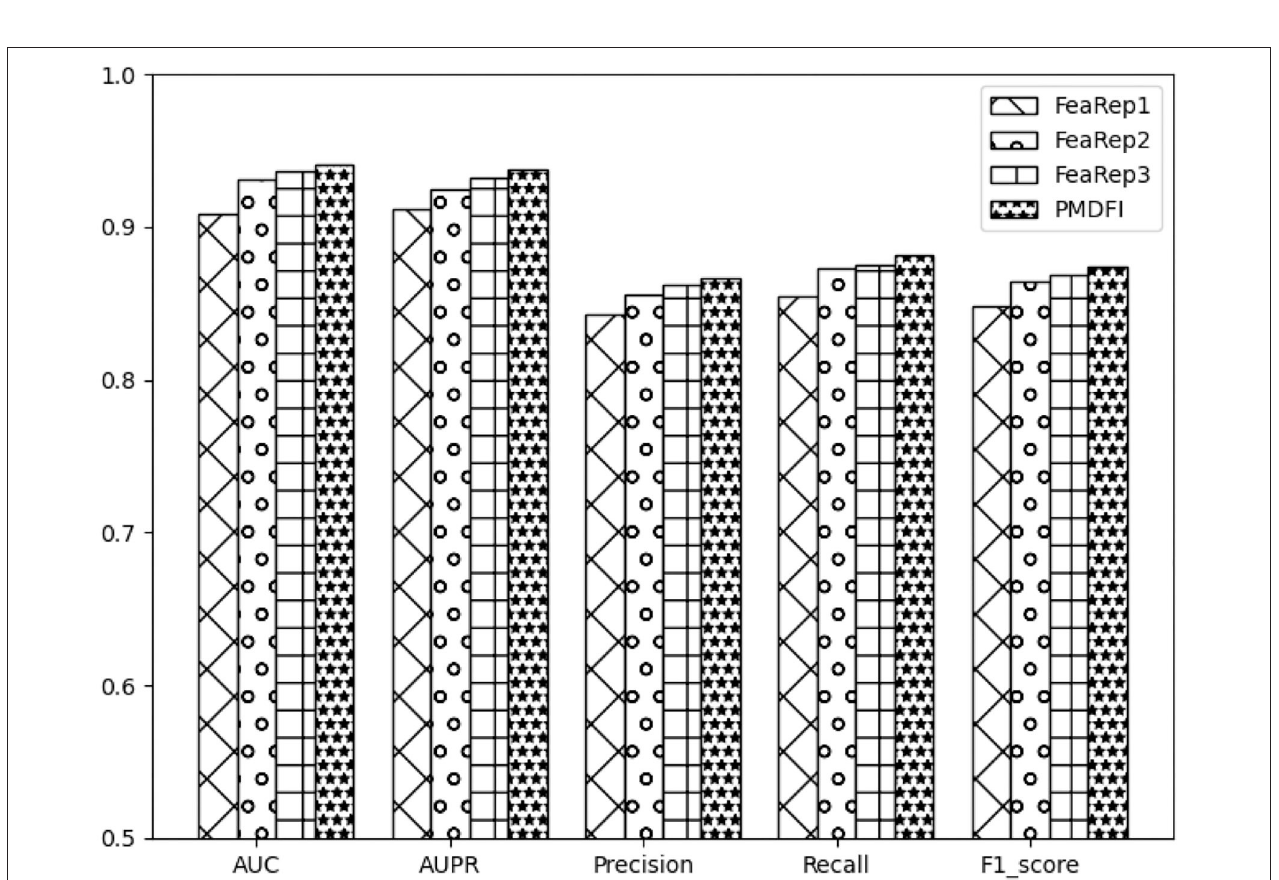
FIGURE 6 | Histograms of comparison of performance based on different feature representation methods.